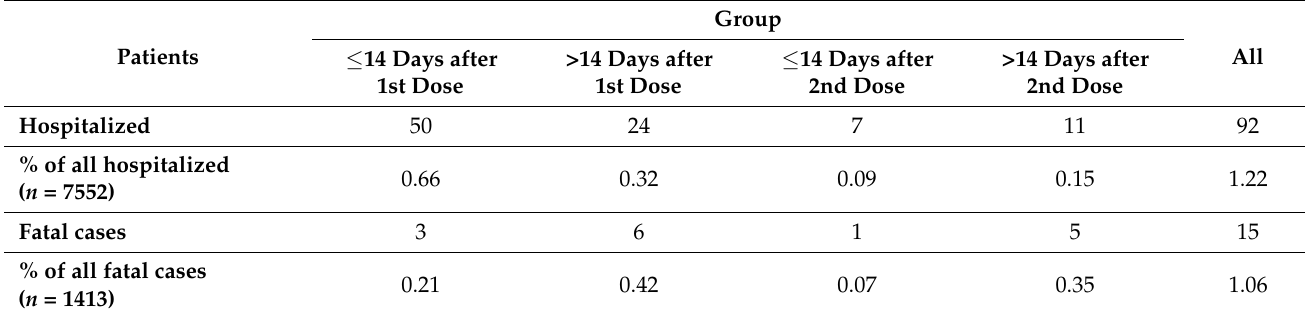
Table 3. The share of patients who received at least one dose of COVID-19 vaccine and were later hospitalized and fatal due to COVID-19 between 27 December 2020 and 31 May 2021 in the Polish healthcare units considered in the present study.